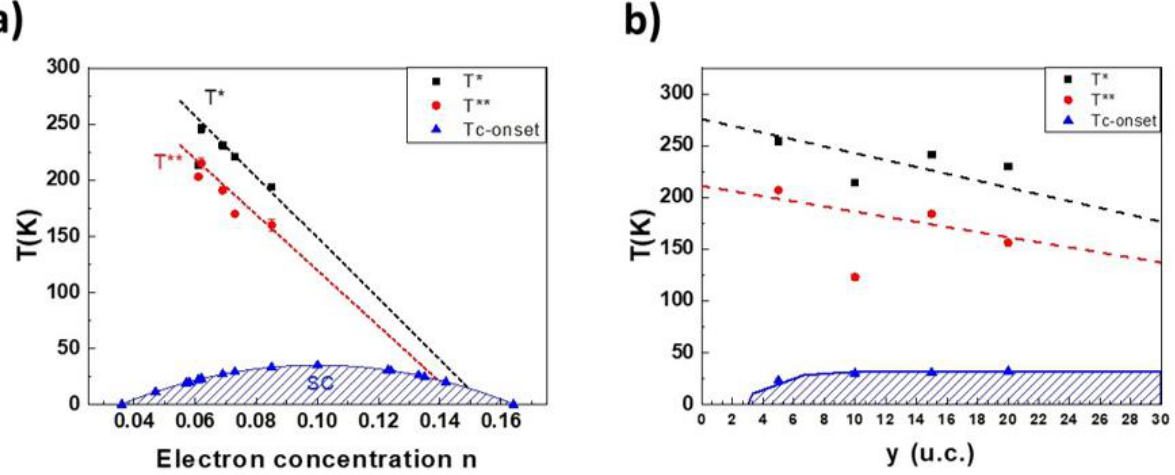
Figure 2. ρ (T) curve for the trilayer with the 15 u.c. thick central layer. The meaning of the T* and T** temperatures is discussed in the text.